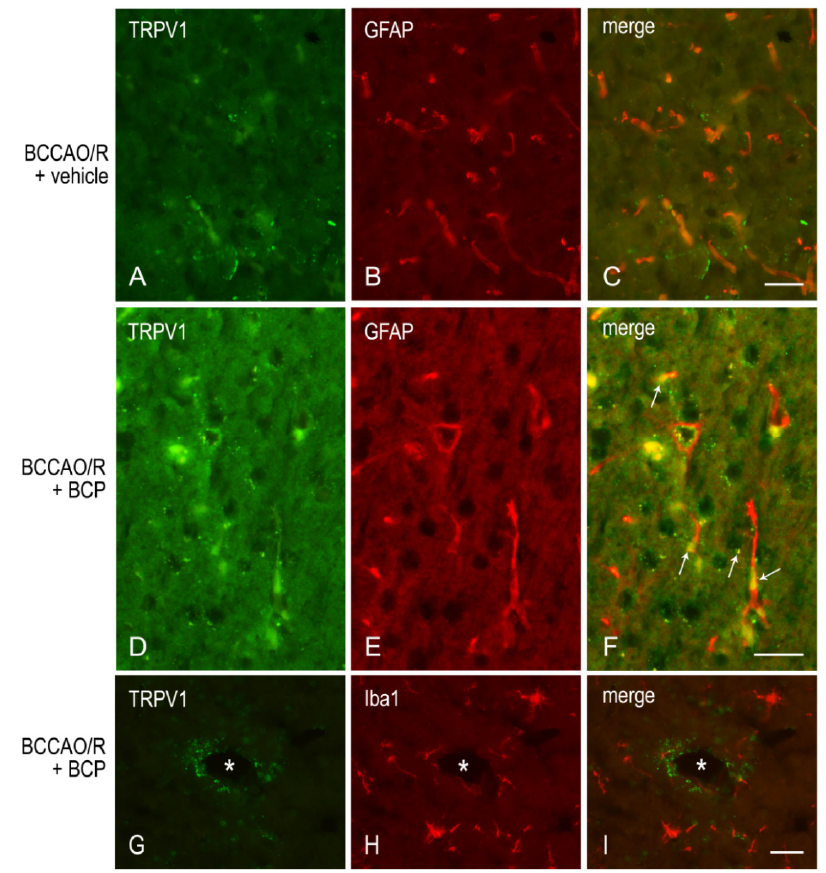
Figure 6. Double immunofluorescence for TRPV1 ( A , C , D , F , G , I ) and either glial fibrillary acidic protein (GFAP) ( B , C , E , F ) or Iba1 ( H , I ) in representative coronal sections of frontal cortex of BCCAO/R + vehicle ( A – C ) and BCCAO/R + BCP rats ( D – F , G – I ); arrows point to TRPV1/GFAP double-labelled elements. *, blood vessel. Scale bars: A, B = C: 25 μ m; D, E = F: 25 μ m; G, H = I: 25 μ m. 3. Discussion The main finding of this study is that the BCP treatment in a single dose exerts preventive effects against the molecular changes induced by the BCCAO/R in the rat frontal cortex. In particular, the BCP-treatment (a) decreases the TRPV1 relative levels in sham rats while increasing them in the BCCAO/R condition; (b) decreases the relative levels of BDNF while inducing a concomitant increase of the trkB levels in both sham and BCCAO/R rats; (d) avoids changing of GFAP protein levels after the BCCAO/R. Addi- tionally, present data enrich the knowledge of molecular markers whose expression is affected by early changes in response to a BCCAO/R protocol with the same length of hypoperfusion/reperfusion used in this study [16,18–20]. Thus, besides the previously reported effects on BDNF and trkB [20], present data support evidence that the BCCAO/R itself causes a sufficient tissue challenge to induce a significant decrease of TRPV1 and GFAP expression levels as compared to sham-operated rats. The transient BCCAO model is the most employed model of global cerebral hy- poperfusion that can be adapted to investigate the efficacy of therapies in acute vascular